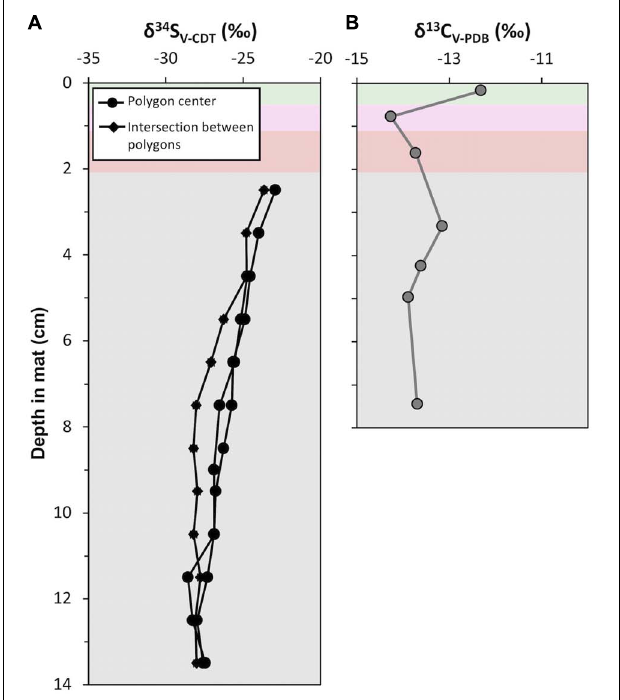
FIGURE 11 | Depth profiles of isotope geochemistry from CC2: (A) Sulfur isotope ( δ 34 S; ) values of porewater sulfide from polygon centers (black line with circle) and an intersection between polygons (black line with squares). (cid:104) Analytical uncertainty in δ 34 S values is ±